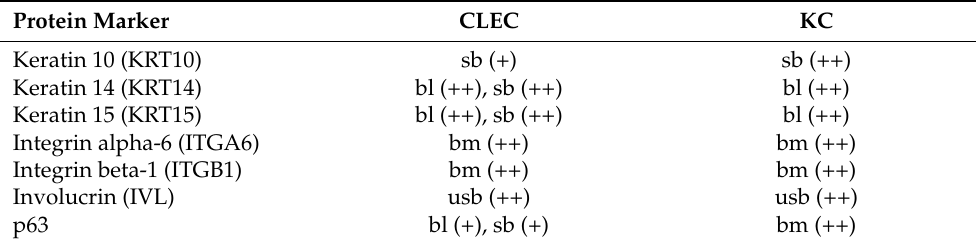
Table 1. Location and distribution of markers associated with human skin epidermis, basement membrane, and epidermal stem cells within the entire epithelia reconstituted by KCs or CLECs in organotypic